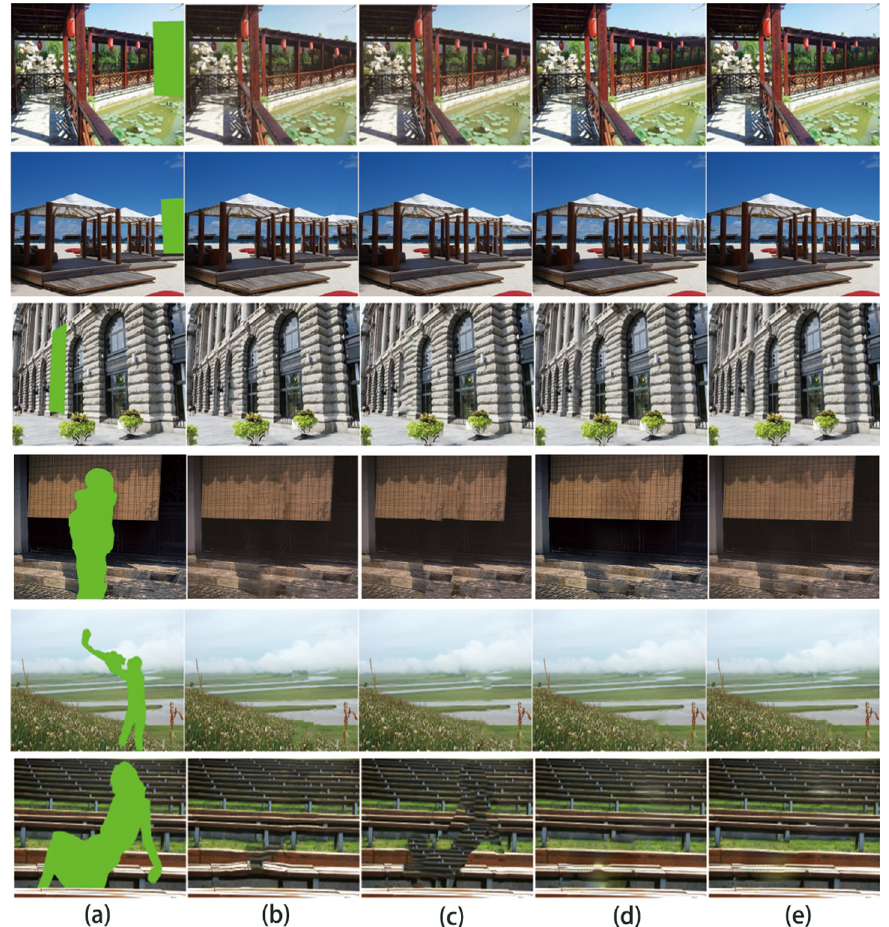
Fig 7. Comparison of relevant results: (a) damaged images, (b) Darabi’s results [20], (c) Barnes’ results [12], (d) Huang’ results [16], (e) our results.